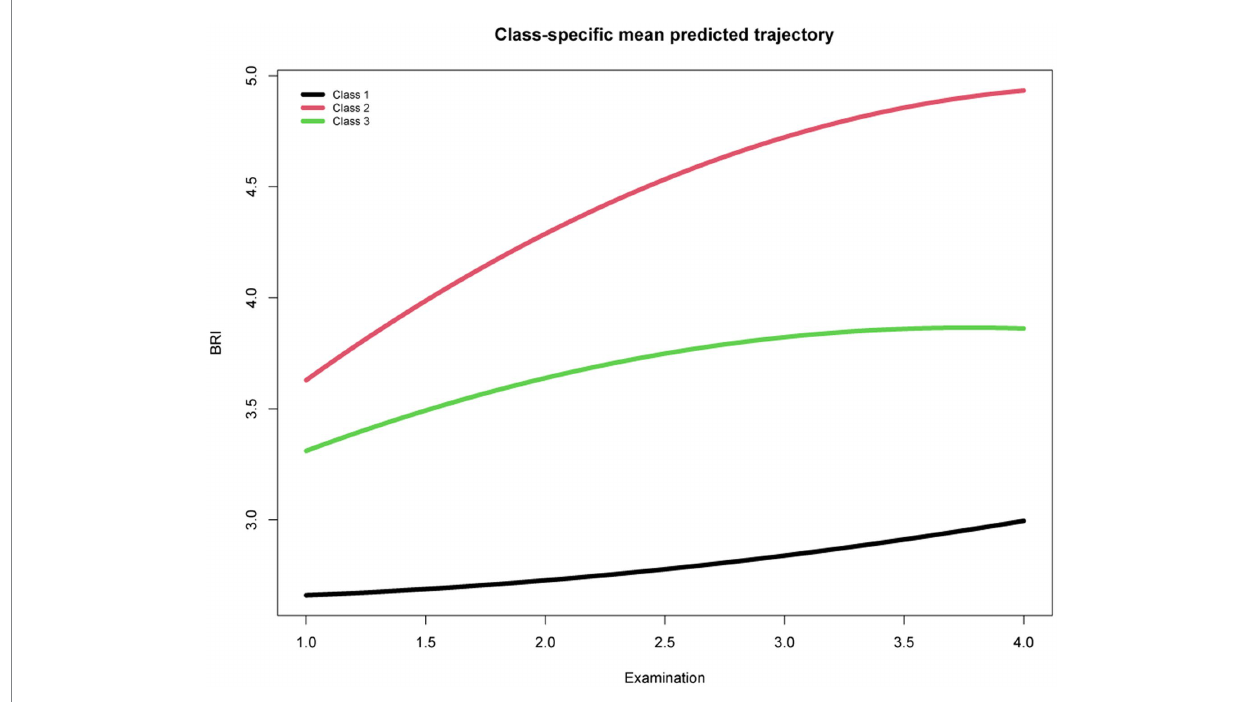
FIGURE 1 Trajectories of body roundness index from the first physical examination to the fourth.